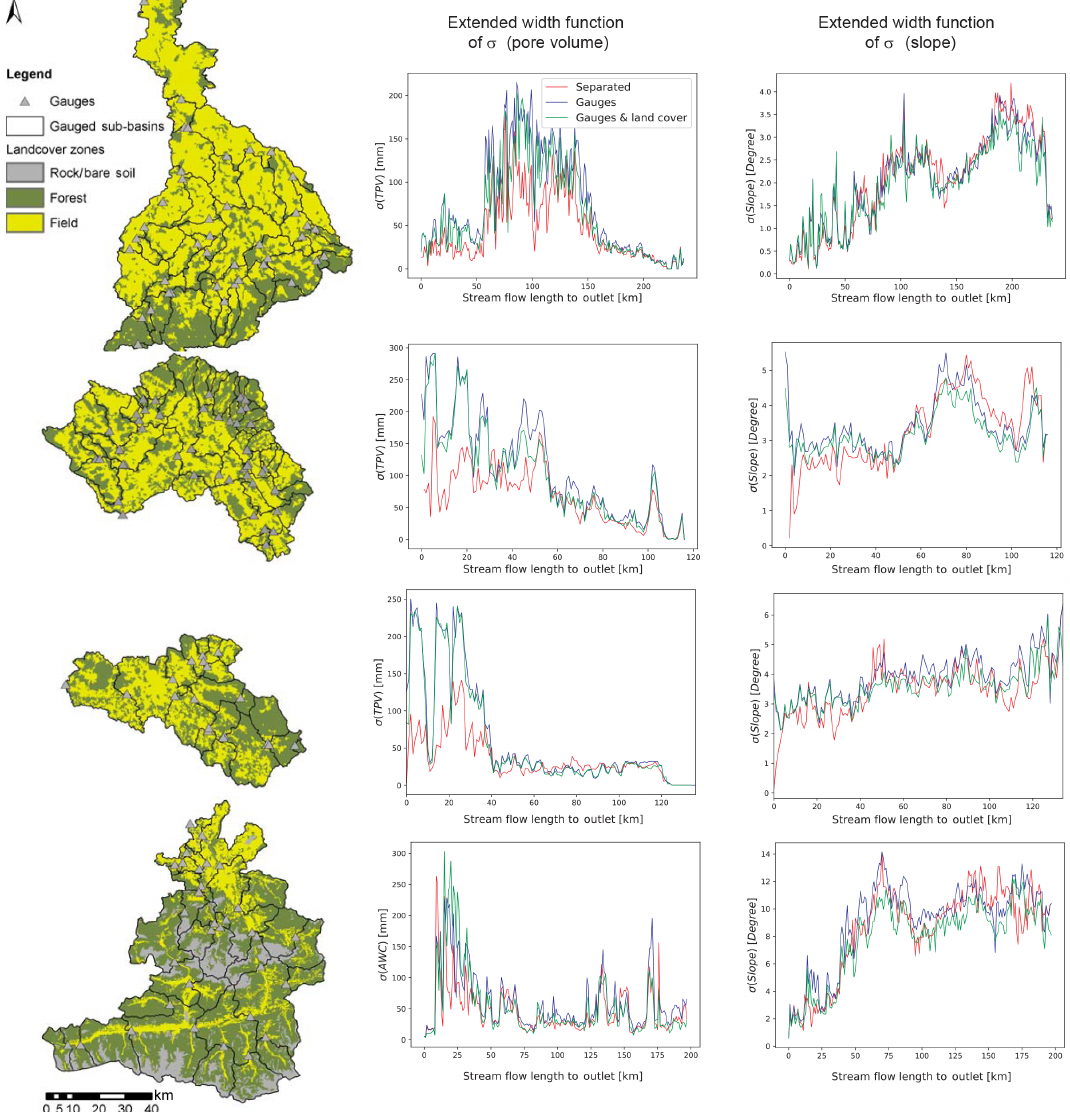
Figure 14. Subdivisions based on gauging network and zonal classification and distance-factor functions of σ (pore volume) and σ (slope) (left to right) for catchments of the Mulde, Main, Regen, and Salzach (top to